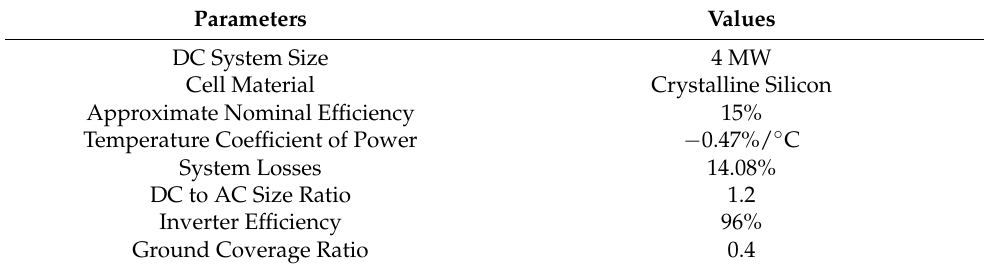
Table 3. Solar generator